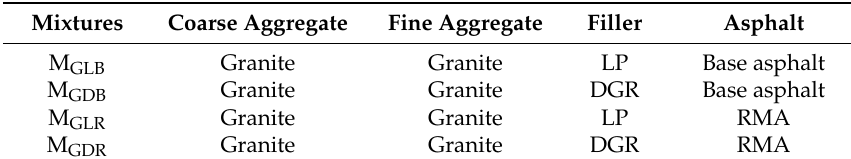
Table 1. Combination of raw materials types for each mixture.